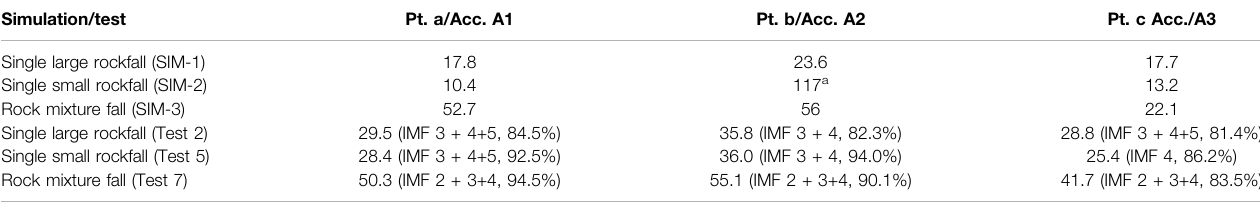
TABLE 4 | Average frequency in Hz of the seismic signals from the simulations and tests.